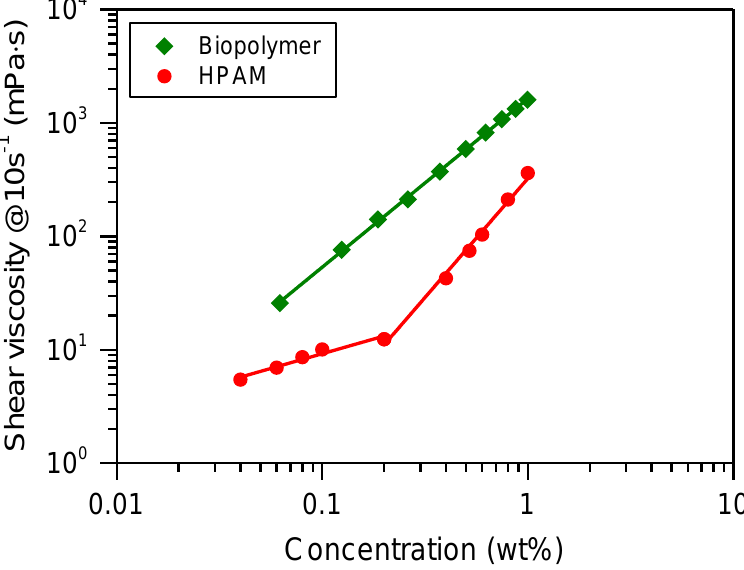
Figure 3. Shear viscosity of polymer solution versus concentration.